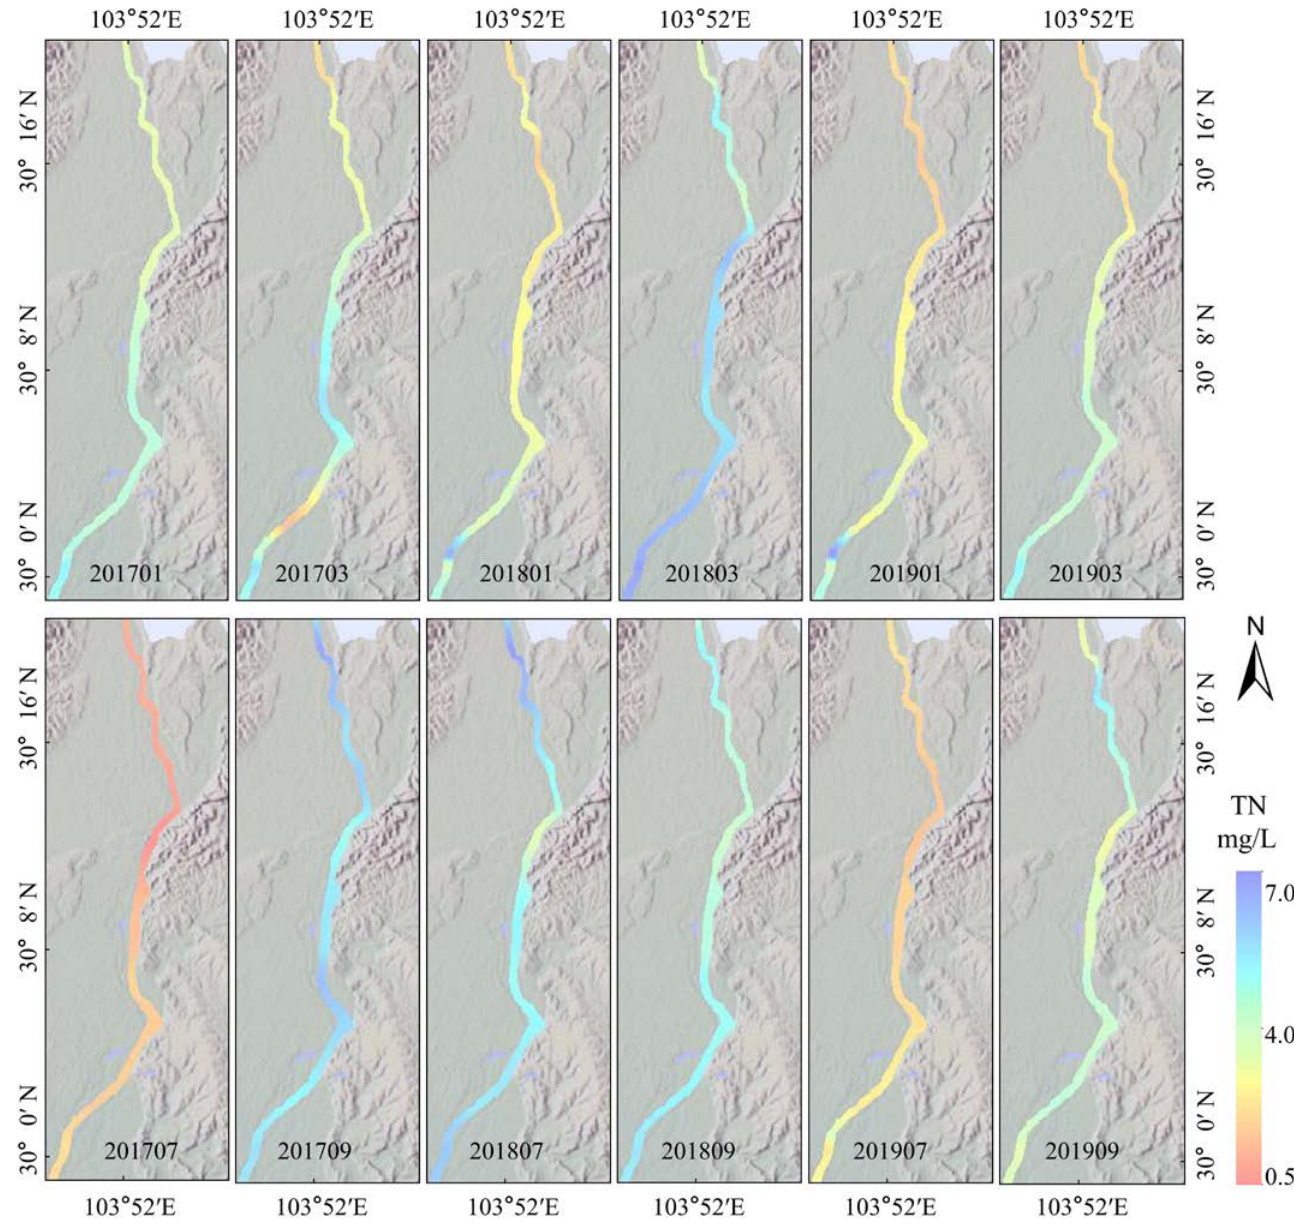
Figure 4. Spatial distribution of TN concentration.